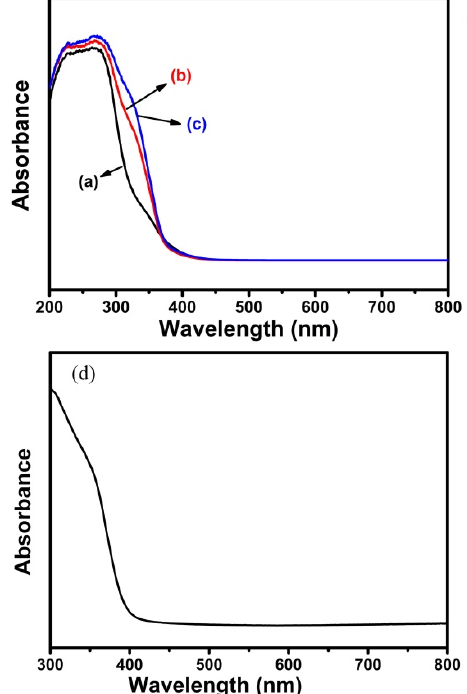
Figure 5. UV-Vis absorption spectra of the as-synthesized sample of ( a ) S1, ( b ) S2, ( c ) S3 and ( d ) TiO 2 synthesized with TBOT via hydrothermal method as a control experiment.